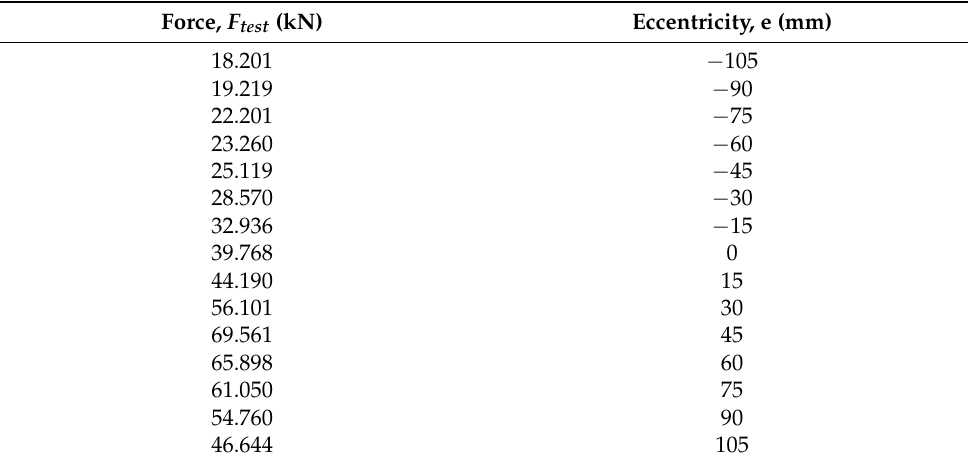
Table 1. List of the maximums of forces and the corresponding eccentricities.